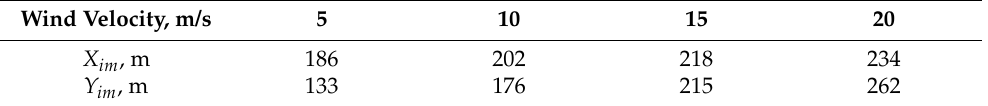
Table 4. The requested minimum maneuvering area within channel bend depending on wind velocity.